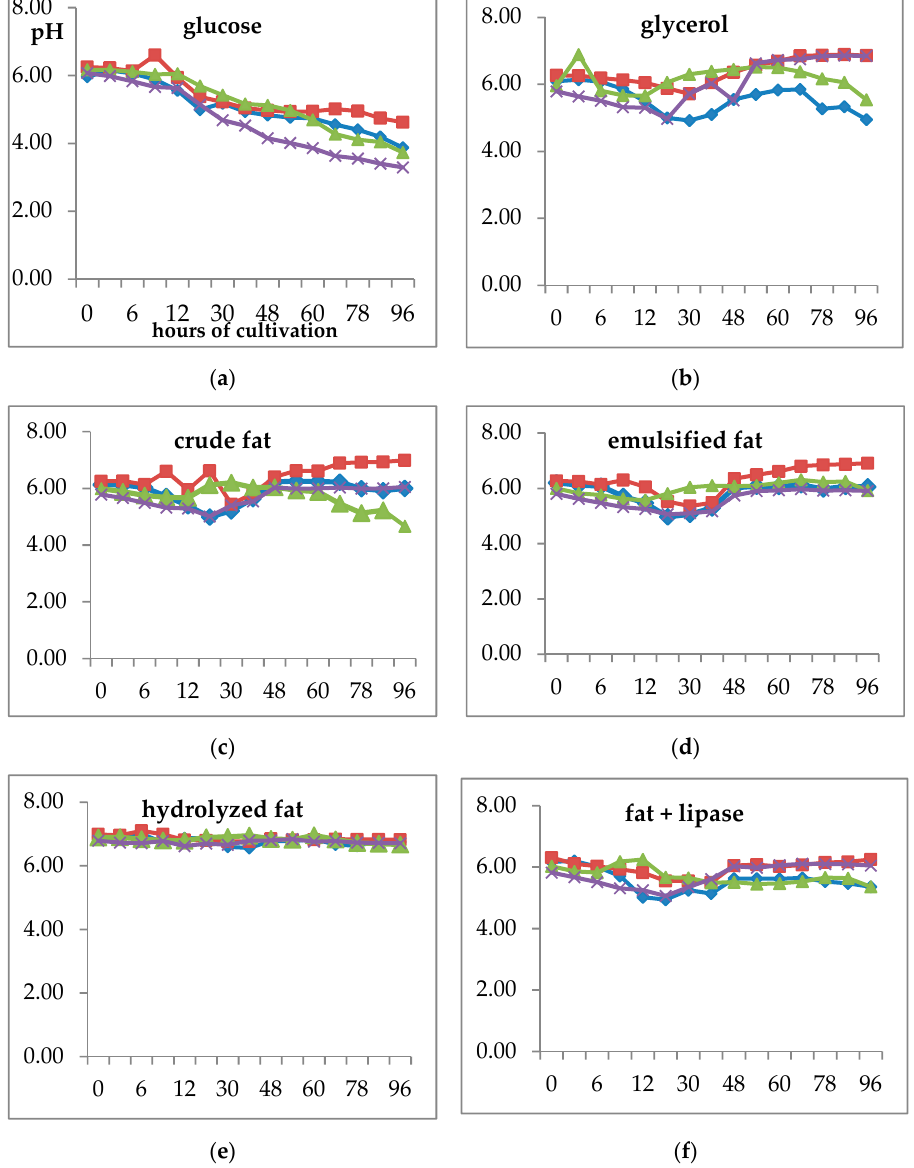
Figure 3. Changes of pH of individual media during yeast cultivation. Changes of pH were recorded in following media: ( a ) Medium with glucose; ( b ) Medium with glycerol; ( c ) Medium with crude animal fat; ( d ) Medium with emulsified fat by Tween 80; ( e ) Medium with enzymatically hydrolyzed fat; ( f ) Medium with animal fat an addition of lipase. Abbreviations: RG ( Rhodotorula glutinis CCY 20-2-26), CM ( Cystofilobasidium macerans CCY 10-1-2), RM ( Rhodotorula mucilaginosa CCY 19-4-6) and SP ( Sporobolomyces pararoseus CCY 19-9-6).